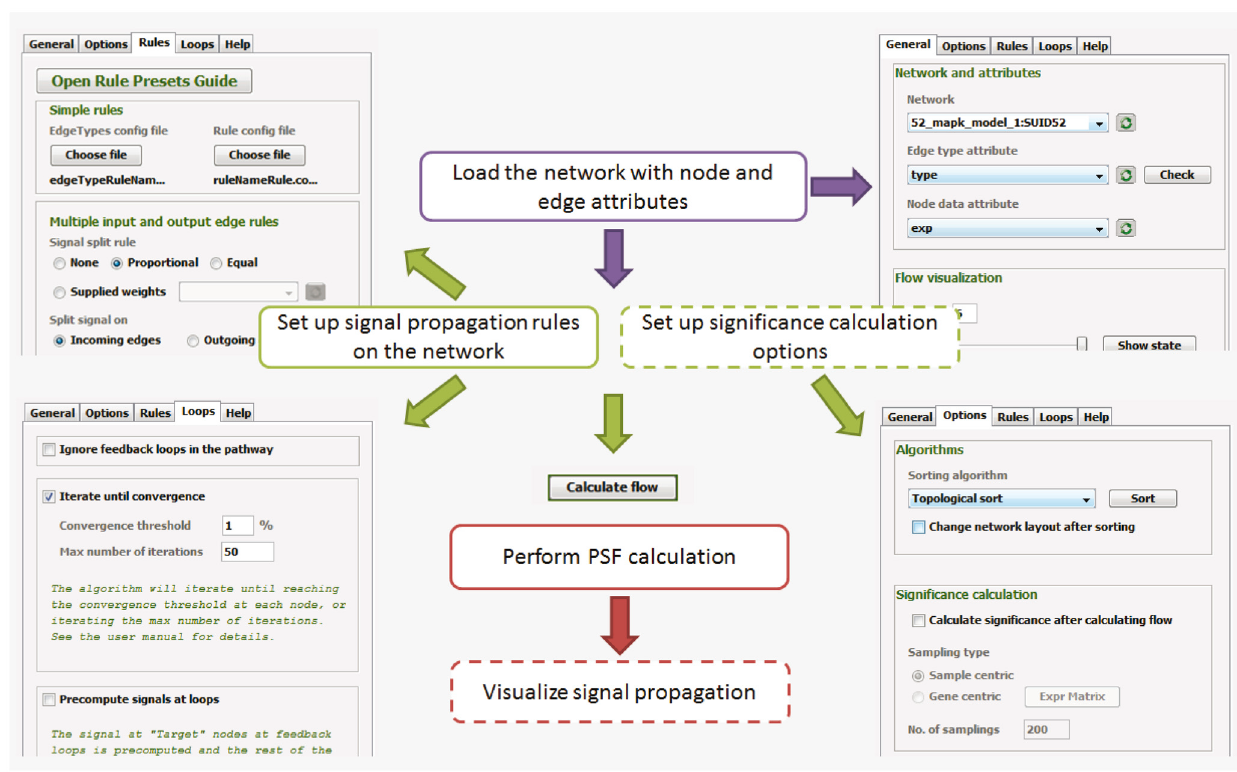
Figure 4. The general use case of PSFC. The user should load the network into Cytoscape, and import node and edge attributes using the Cytoscape environment. Further, the user sets the rules for signal propagation, loop handling and significance calculation. After PSF calculation, the signal propagation may be visualized in Cytoscape. The dashed rectangles are